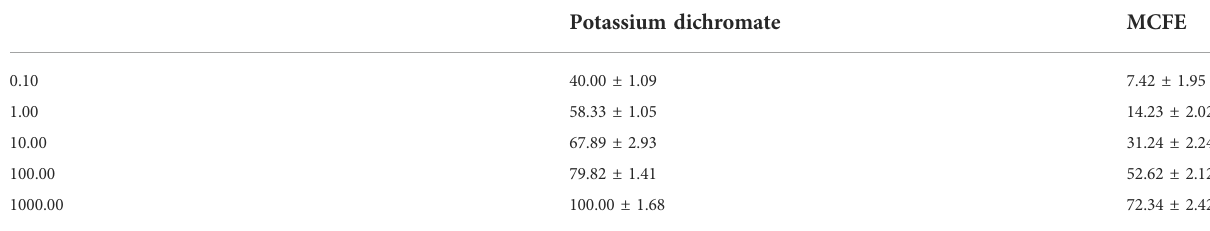
TABLE 1 Brine shrimp lethality assay of a standardized